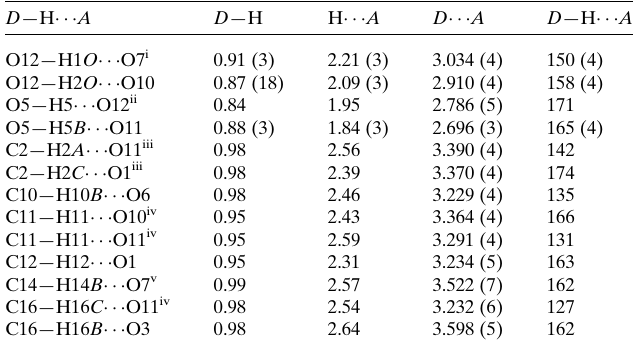
Table 5 Hydrogen-bond geometry (A˚ , (cid:5) ) for 4 .